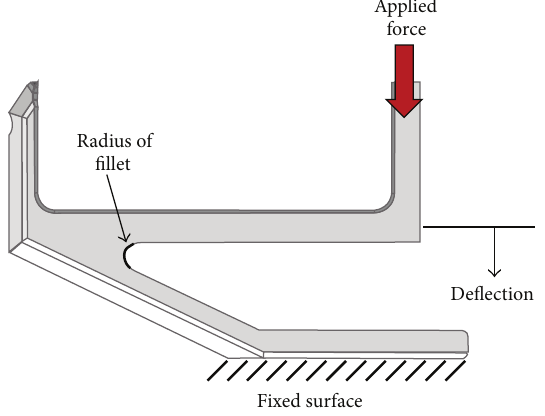
Figure 10: Force and the boundary conditions and the design parameter of the fork. Table 2: Equivalent stiffness with respect to the radius of fillet. Radius of fillet